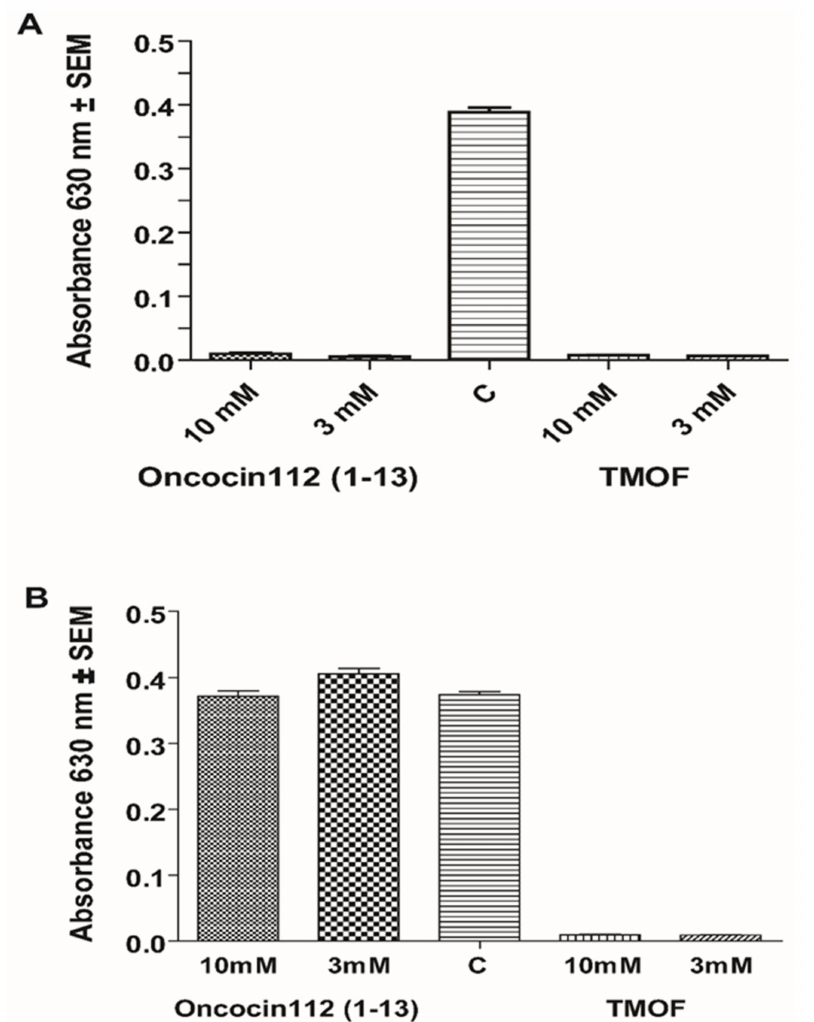
Figure 7. Incubation of E. coli cells with Oncocin112 (1–13) and Aea TMOF at concentrations of 3 and 10 mM ( A ) with E. coli cells expressing SbmA and ( B ) with E. coli mutant cells SbmA - expressing the ABC- tmf A importer. Control cells incubated without oncocin112 (1–13) or Aea TMOF